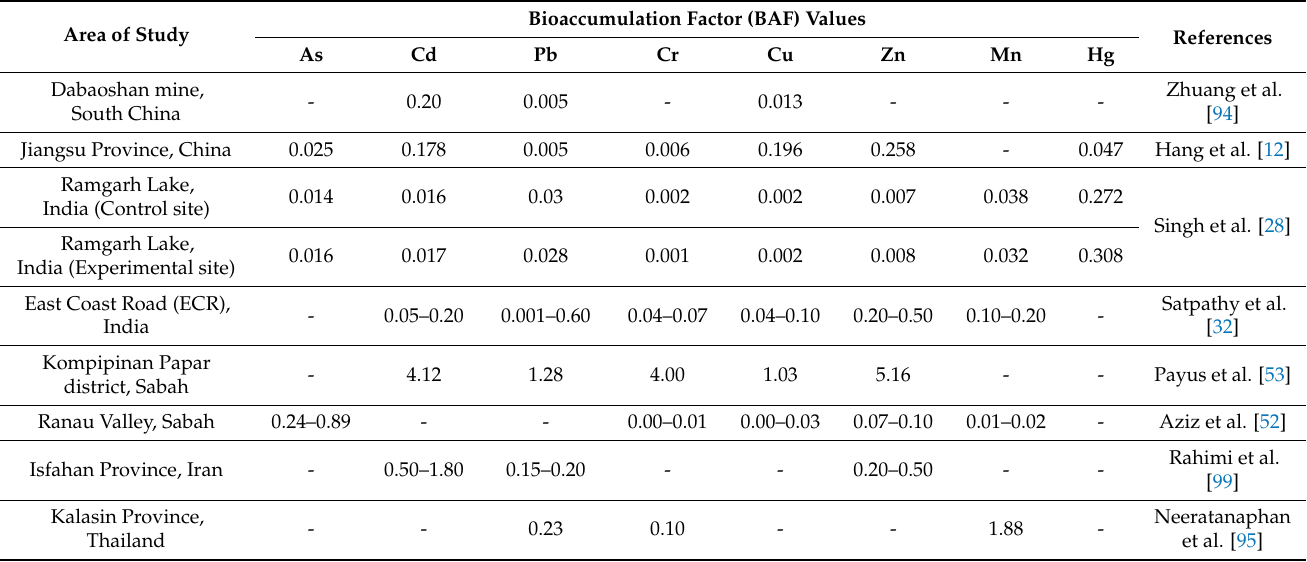
Table 2. Summary of the bioaccumulation factor (BAF) values in paddy plants from different areas. Area of